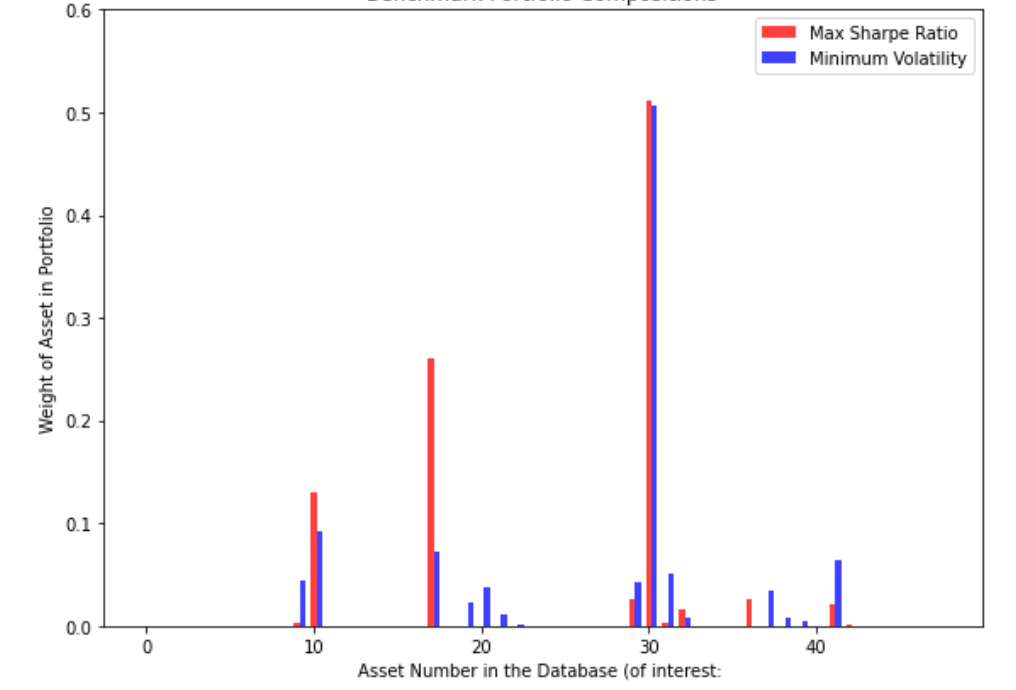
Figure 22. Benchmark portfolio optimization: Weights and Sharpe